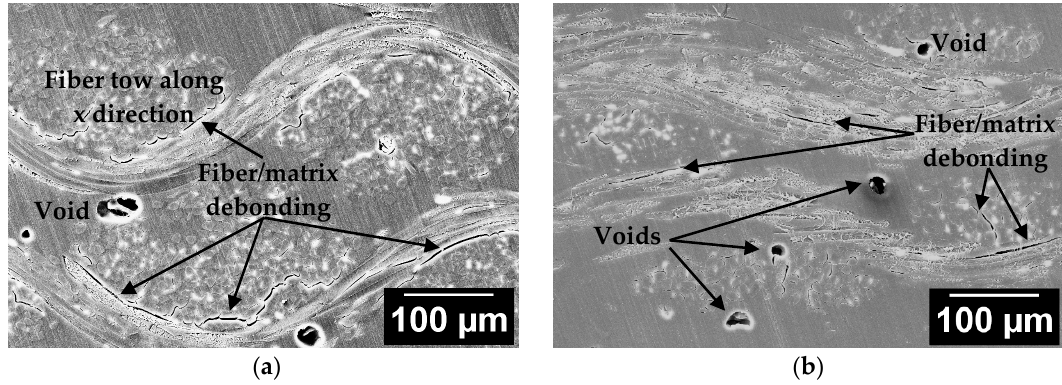
Figure 8. Sample SEM images at 200 × of the microstructure of silk/epoxy laminate cross-sections ( a ) along the y direction and ( b ) along the x direction.